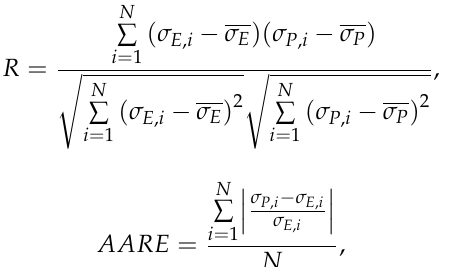
)) and ln ( ε − ε c ) drx ε p